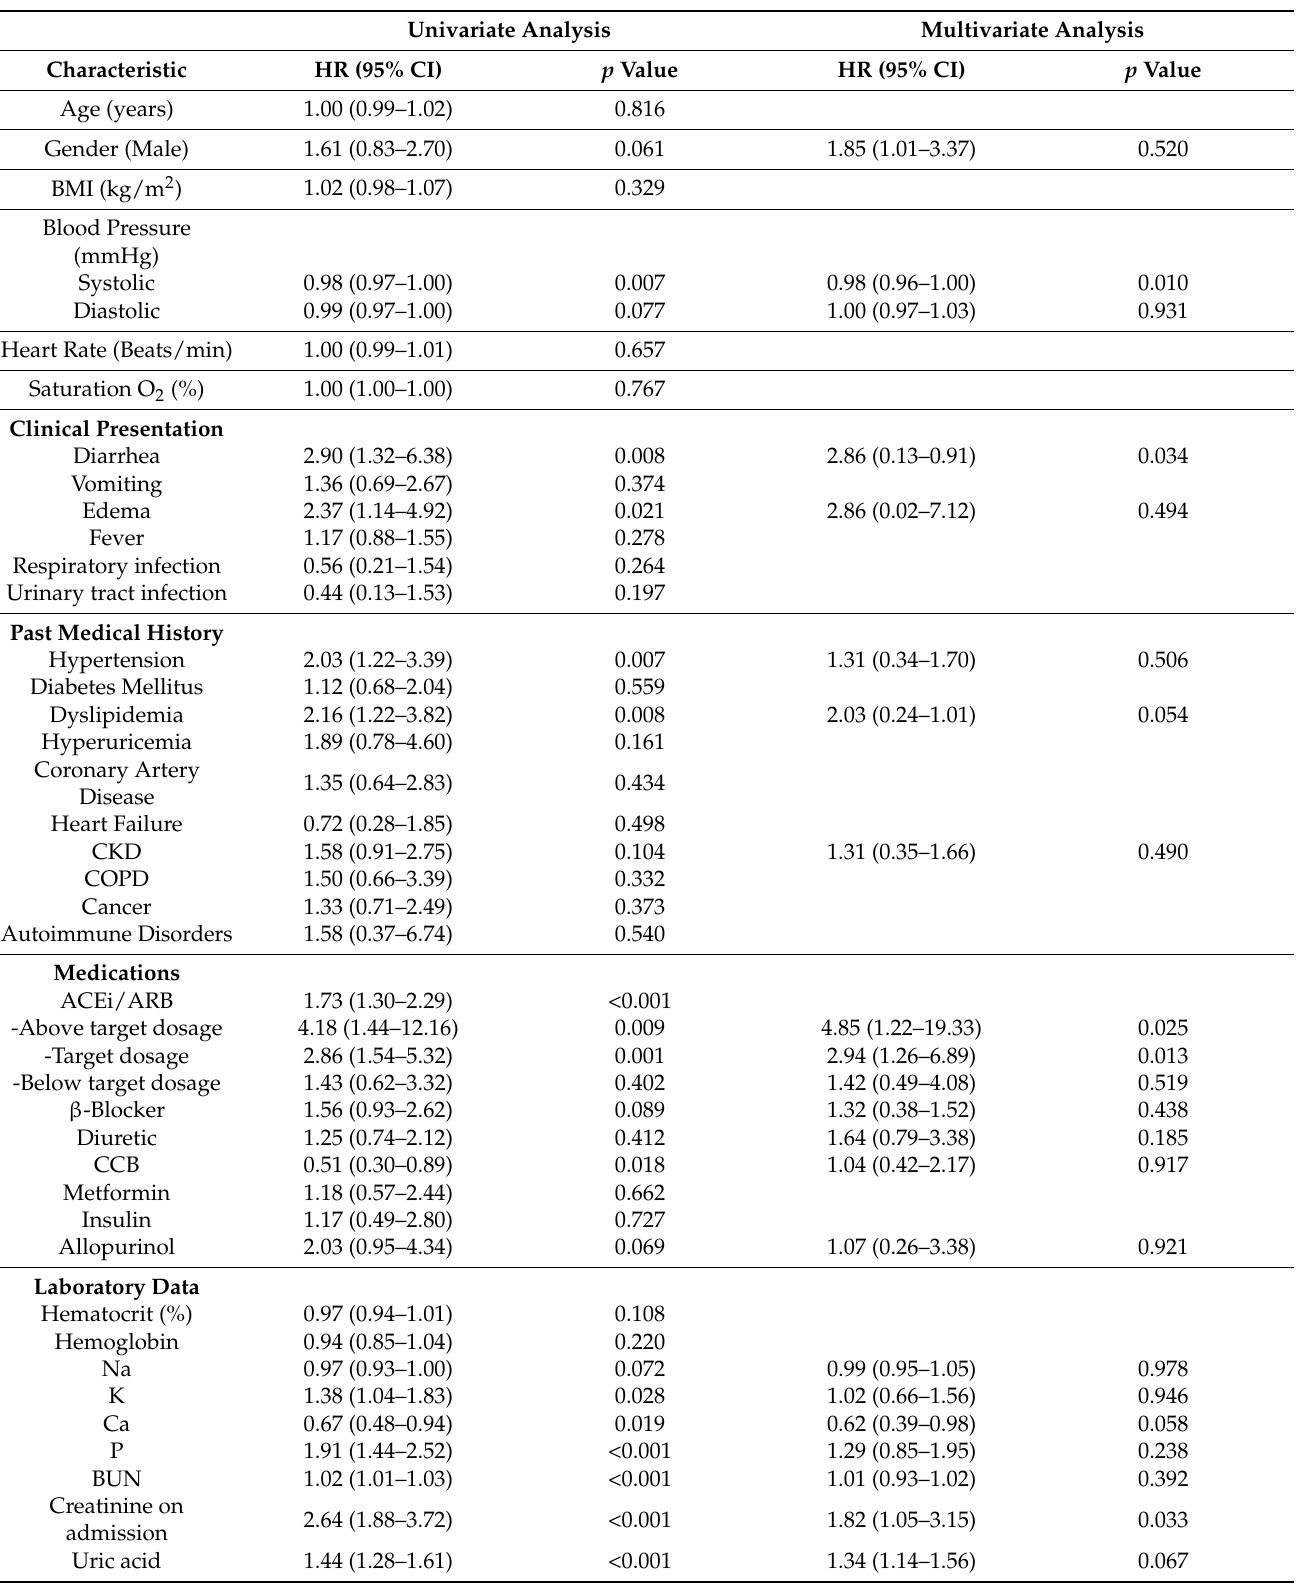
Table 4. Univariate and multivariate logistic regression analysis. Univariate Analysis Multivariate